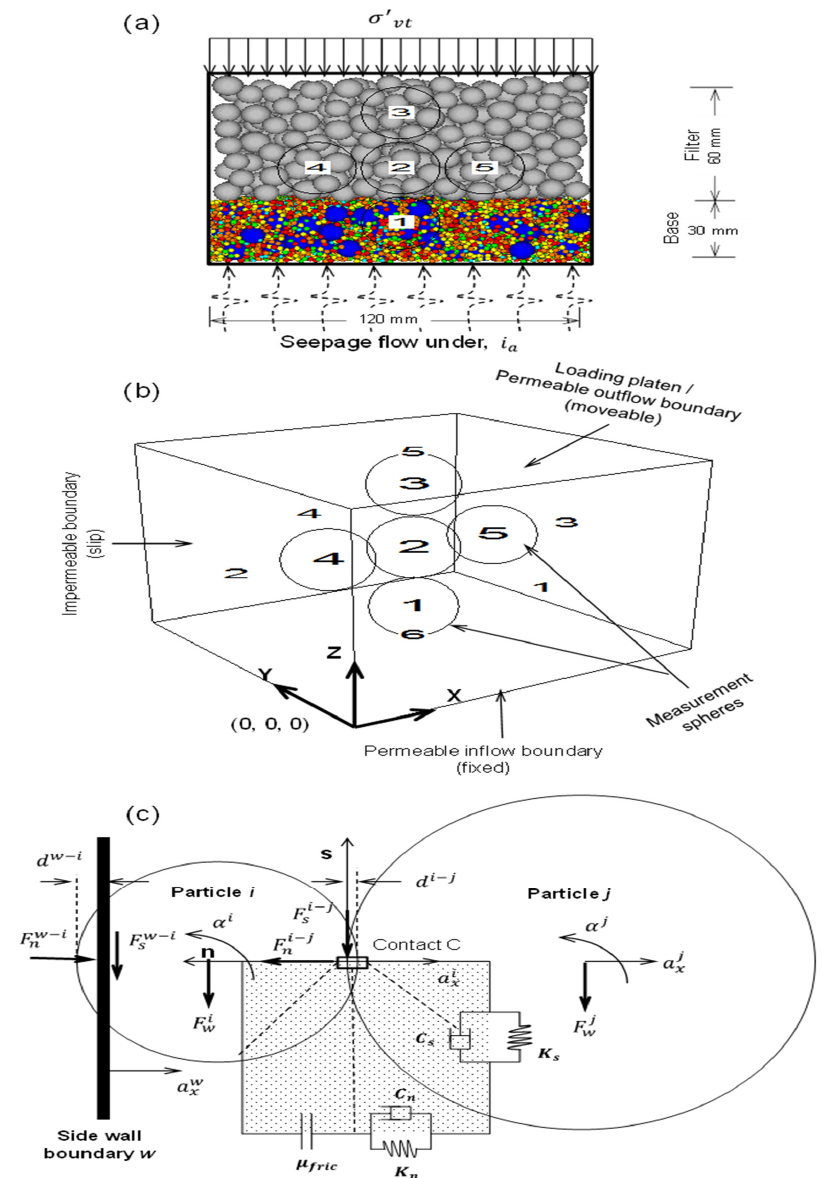
Figure 2. Illustration of ( a ) simulation cell, ( b ) numerical model specimen, and ( c ) the Hertz–Mindlin contact model.